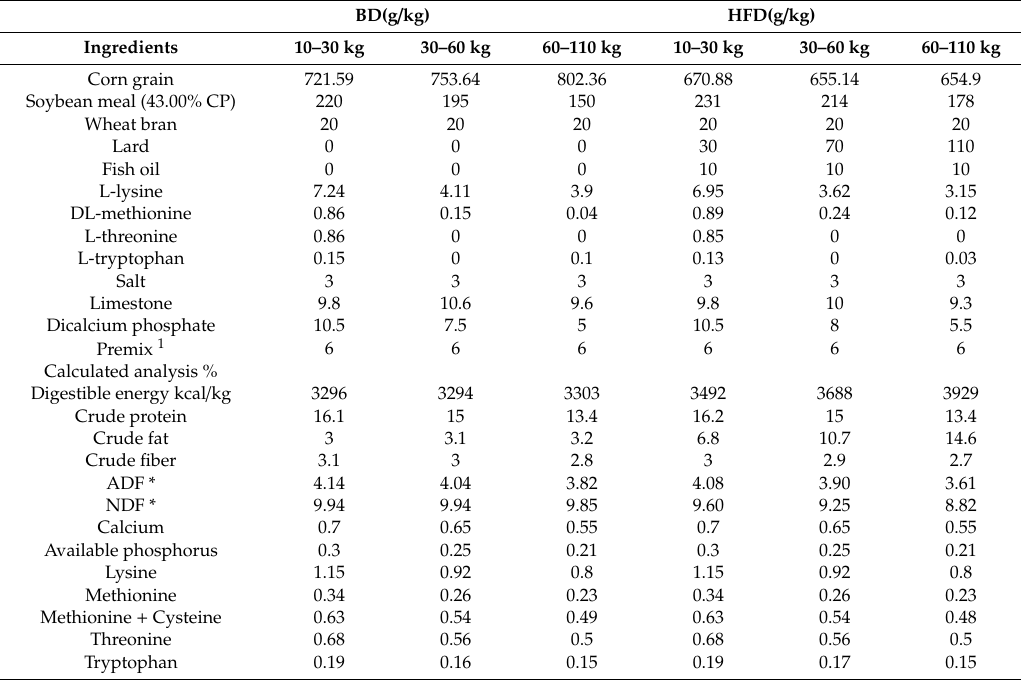
Table 1. Ingredient and nutrient levels of the basal